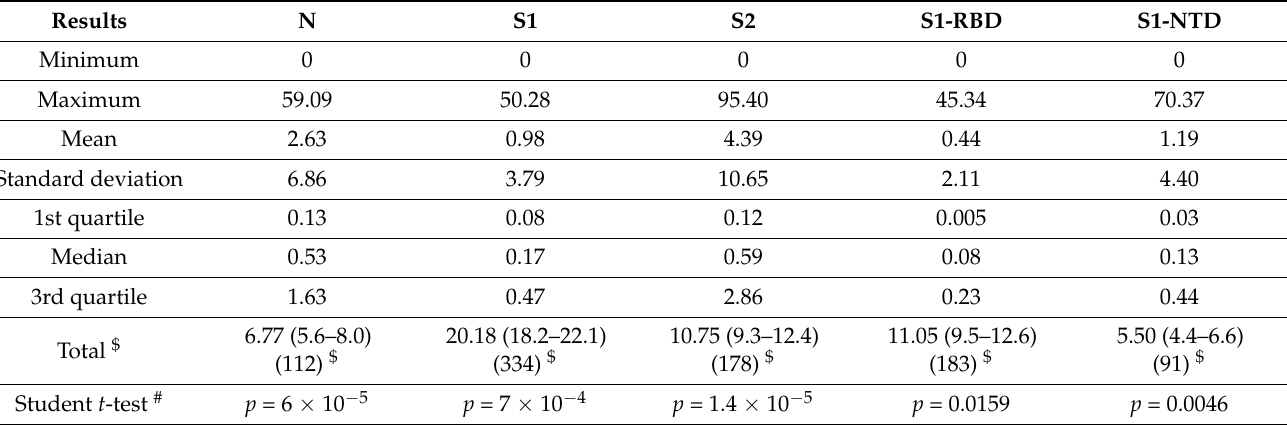
Table 2. Samples values, obtained by differential optical density (1655 samples). For each antigen, the table indicates the distribution of values and the number of samples with value above the threshold (percentage and 95% confidence interval, count). The p -value of the Student t -test indicates the probability of no difference between the mean of Central Africa samples and the mean of control samples.